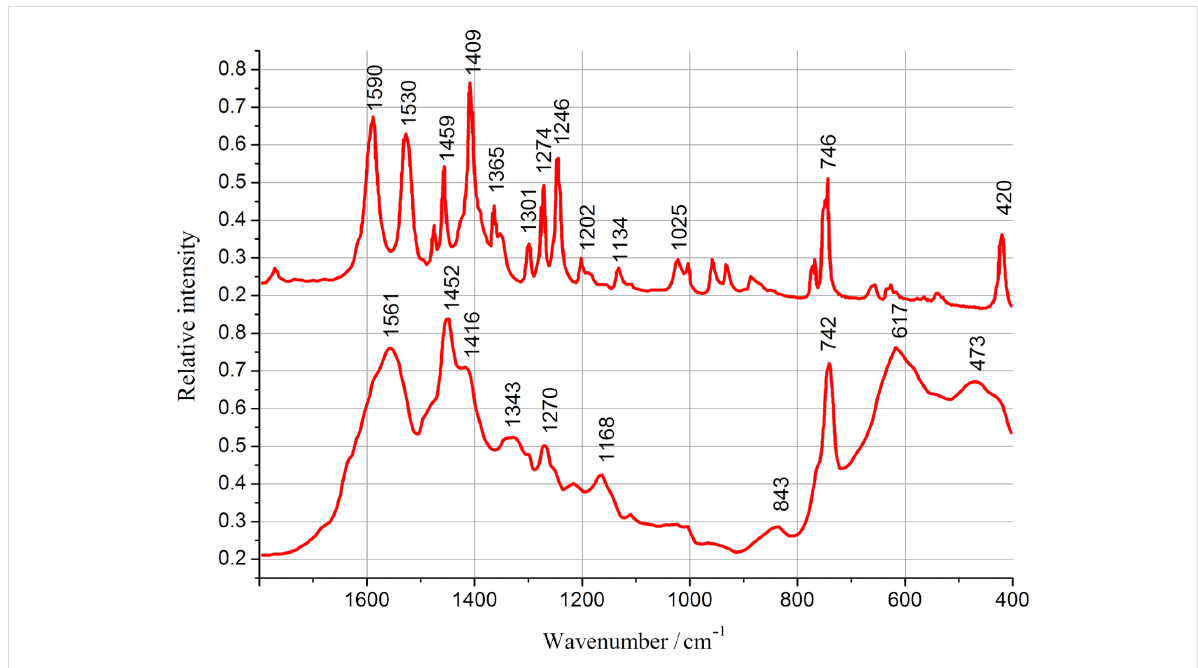
Figure 4: FT-IR spectra of a mixture of BI with Zr(acac) 4 (4:1 molar ratio, upper spectrum) and of the product of the reaction occurring after heating of this mixture to 320–350 °C (lower spectrum).